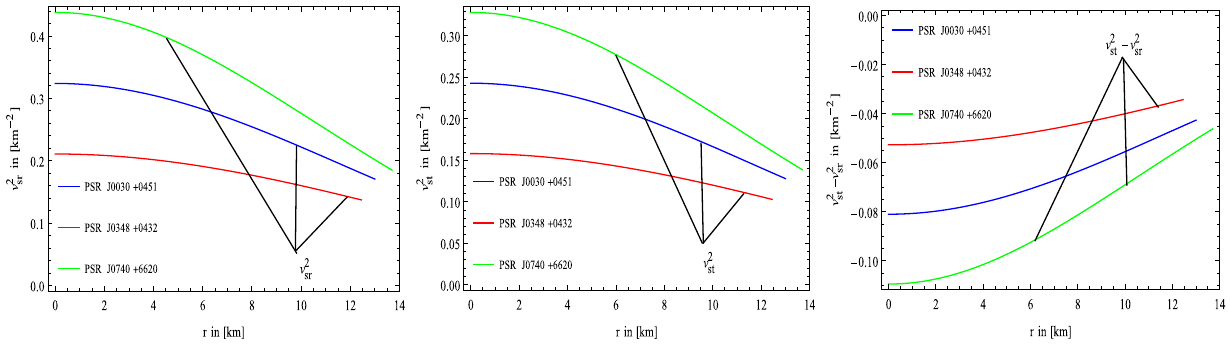
Fig. 3 Behaviourofthesquareofradialandtransversespeedsofsound ( v 2 r , v 2 t ) and the difference between the square of radial and transverse speeds of sound against the radial coordinate r of our stellar model for